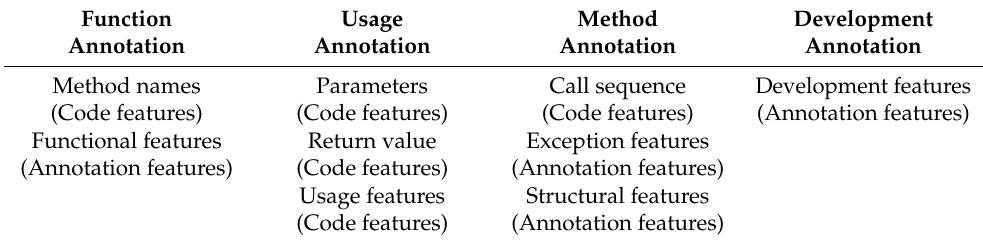
Table 1. Multidimensional code annotates